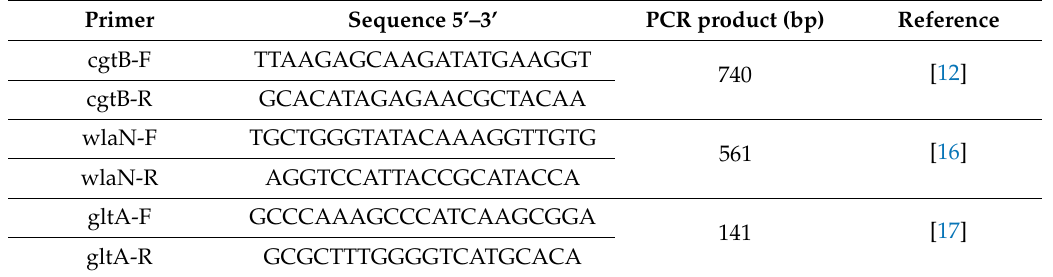
Table 1. Primers used in this